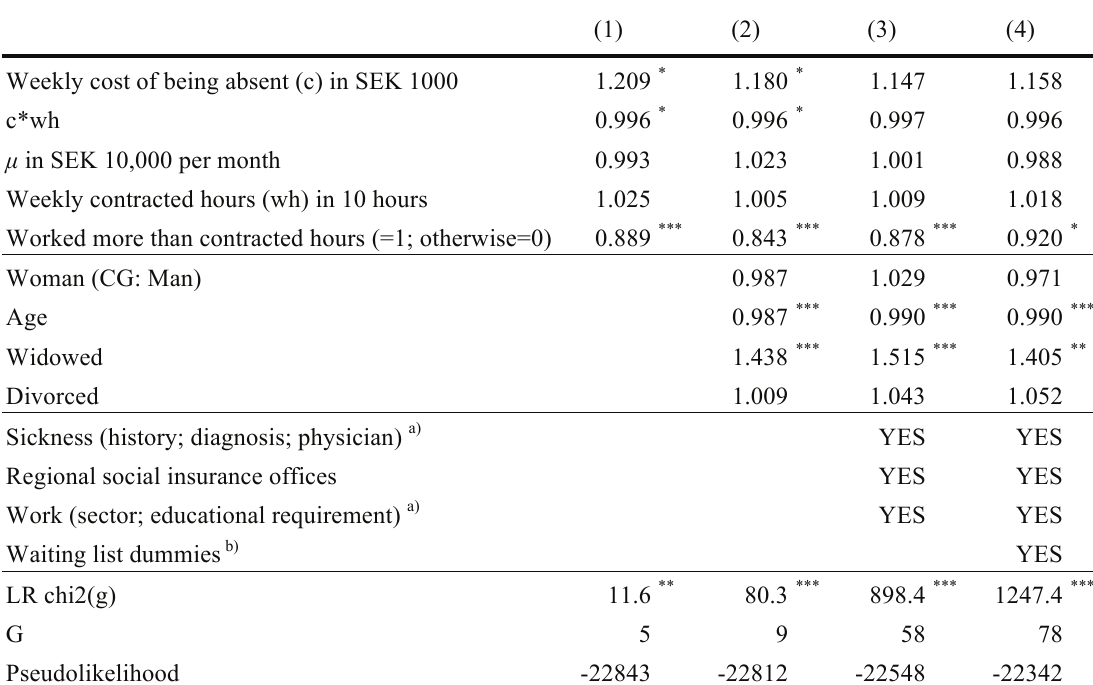
Hazard ratio estimates: economic and demographic